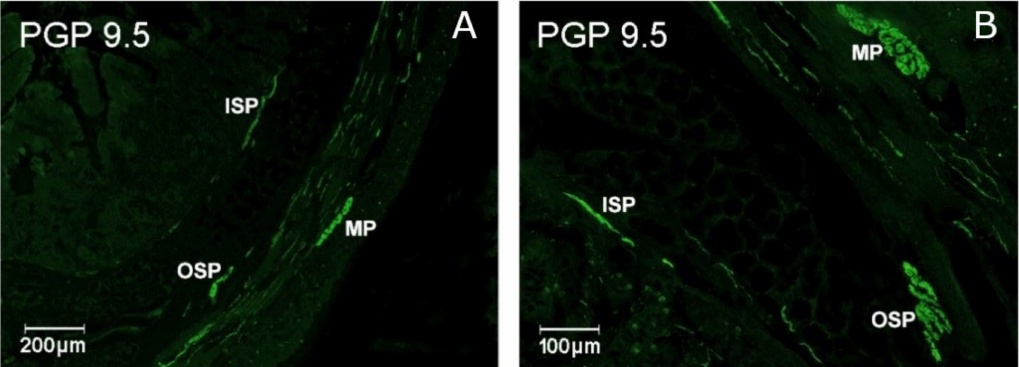
Figure 1. Organization of the enteric nervous system in the porcine jejunum demonstrated by the labeling with protein gene-product 9.5 (PGP 9.5)—used as a pan neuronal marker. Elements of the enteric nervous system: MP, myenteric plexus; OSP, intestinal outer submucosal plexus; and ISP, intestinal inner submucosal plexus. Scale bars indicate 200 µ m ( A ) and 100 µ m ( B